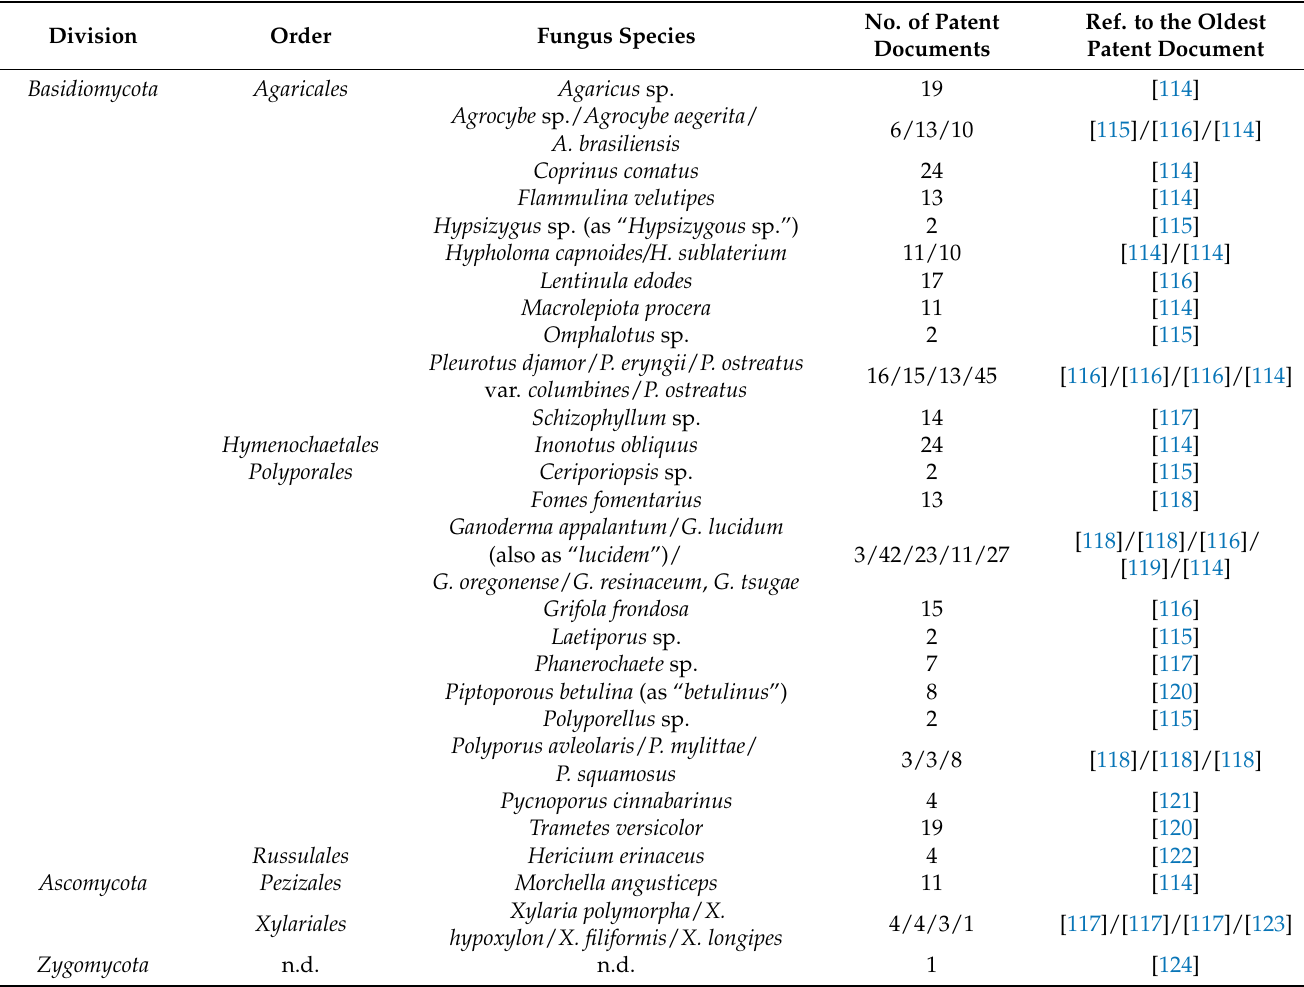
Table 2. Fungus species in patent